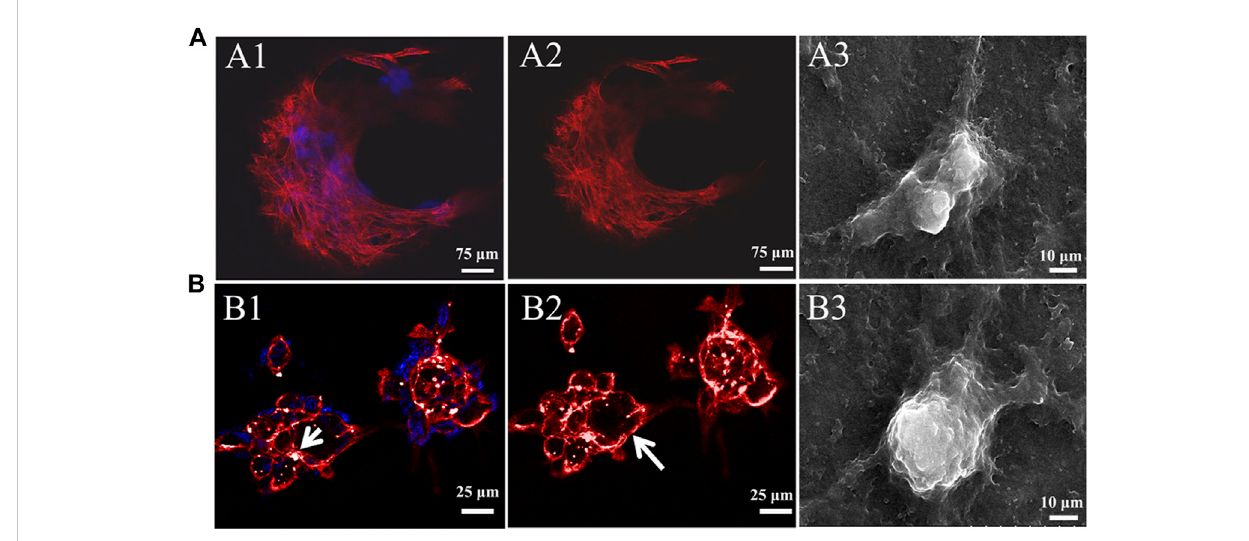
FIGURE 4 CLSM images of the cytoskeleton of chondrocytes on (A) High-G/M (A1-A2) and (B) Mid-G/M (B1-B2) ALG/COL hydrogels after 7 days of culture in vitro . Cytoskeleton (red), nucleus (blue). Scale bars are 25 μ m. A white arrow indicates a rounded cell aggregate. SEM micrographs of chondrocytes cultured on composite alginate hydrogels with (A3) High-G/M and (B3) Mid-G/M samples, respectively. (5000 × magni fi cation, scale bar = 10 μ m).